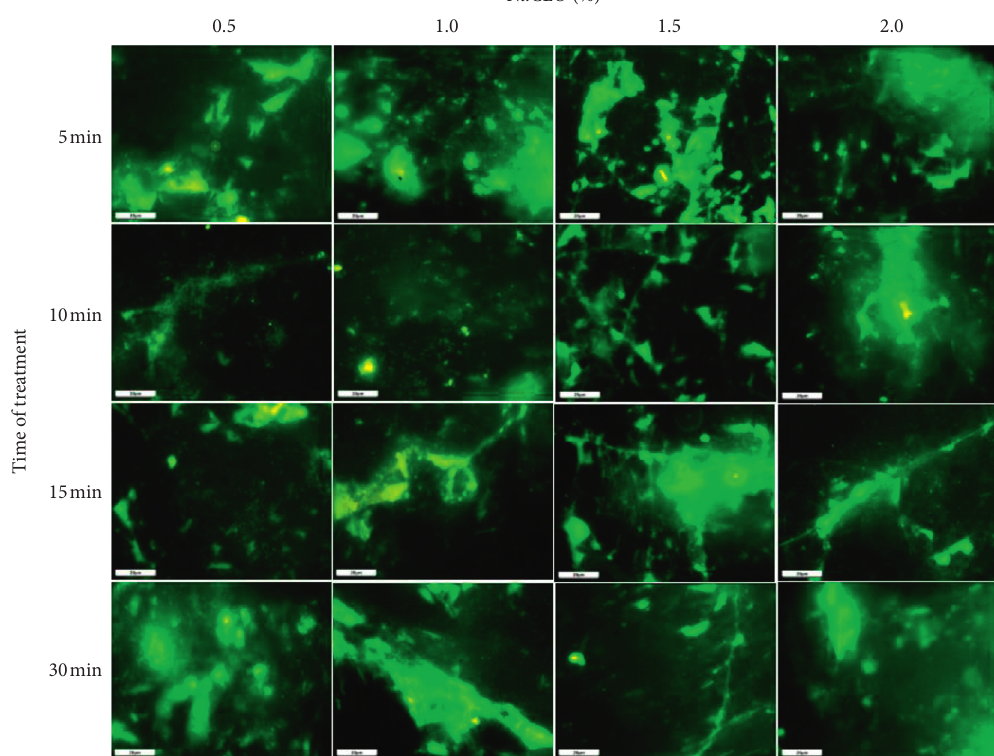
Figure 12: Effectiveness of NaCLO against P. aeruginosa biofilm installed on the granite Rosa Porrino at the concentration of 0.5, 1, 1.5, and 2% after 5, 10, 15, and 30min of